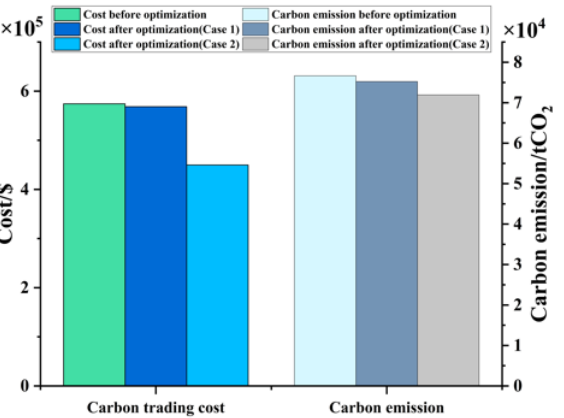
Figure 16. The carbon trading cost and carbon emissions before and after the optimization in Case 1 and Case 2.